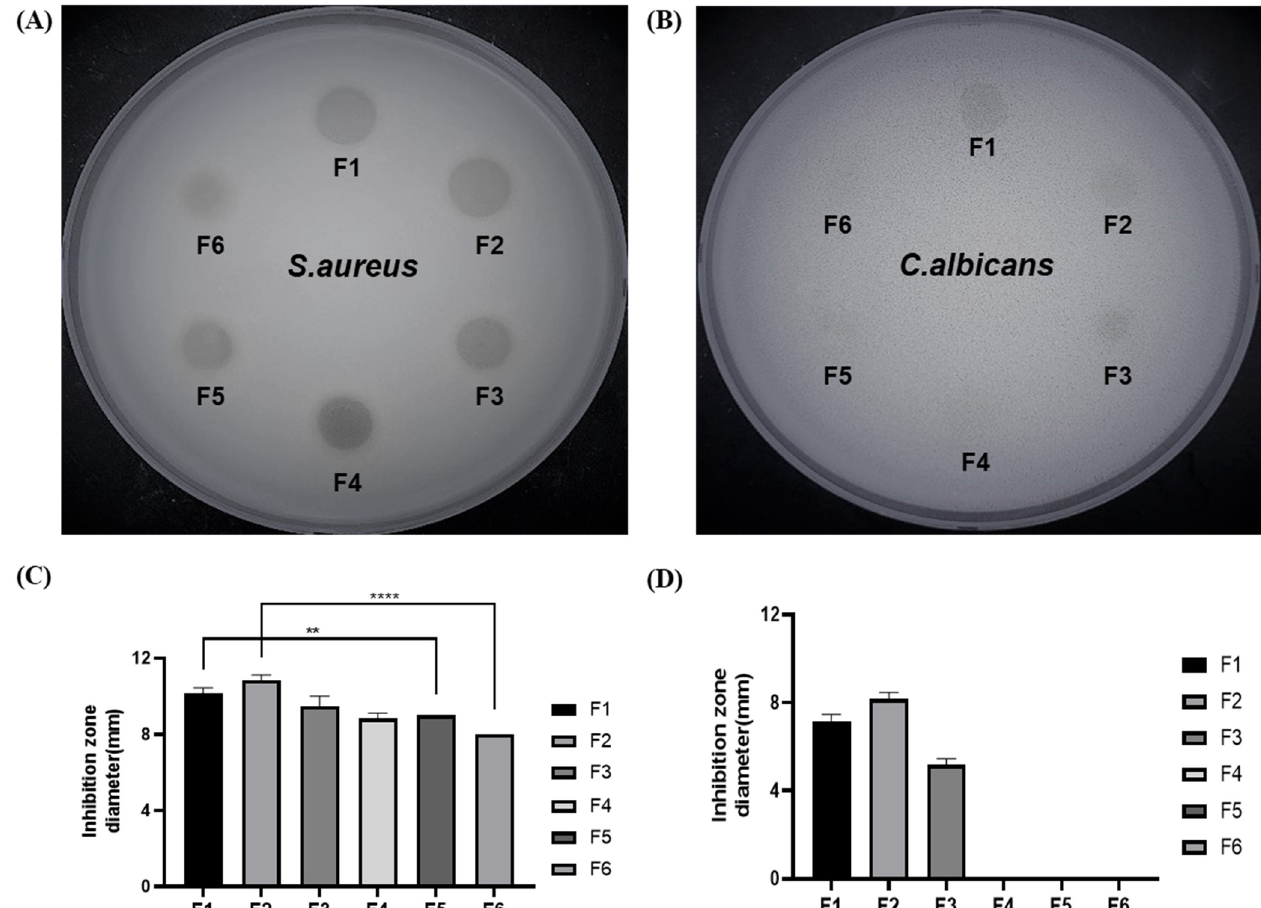
Figure 5. Representative agar plates from antimicrobial susceptibility test of ( A ) S. aureus and ( B ) C. albicans . The diameters of the zone of inhibition (clear zone around each well) were measured with a caliper in millimeters and expressed as mean ± S.D. ( n = 3) for ( C ) S. aureus and ( D ) C. albicans . ** p < 0.01, **** p < 0.0001 compared to the control, two-tailed student’s t-test.